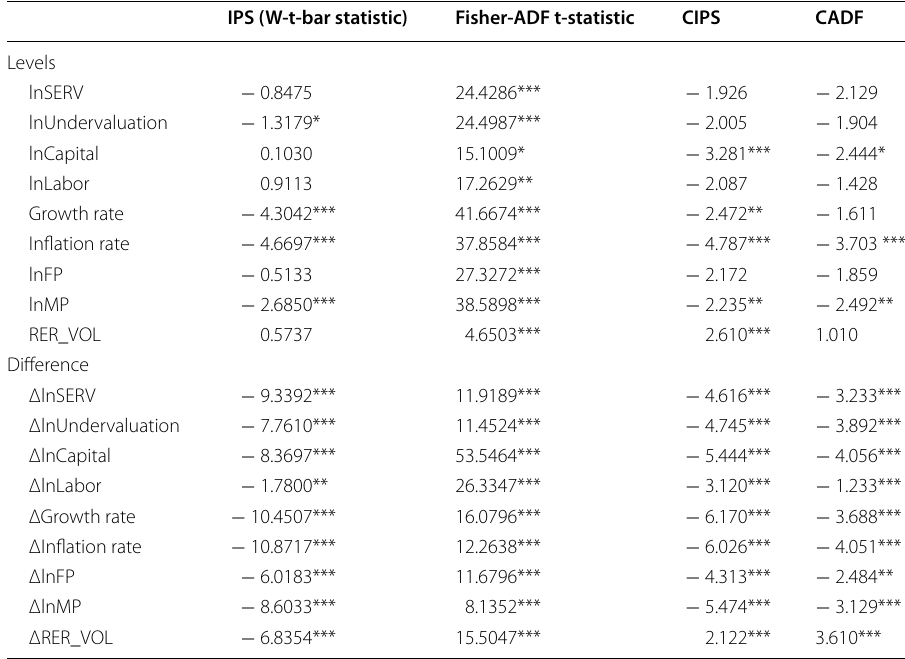
Lag lengths were selected automatically using the Schwarz information criterion (SIC); 2 maximum lags selected; All the tests have as H0: non-stationarity; ∆ is the first difference operator *, **, ***Indicate rejection of the null hypothesis at 10%, 5%, and 1%, respectively